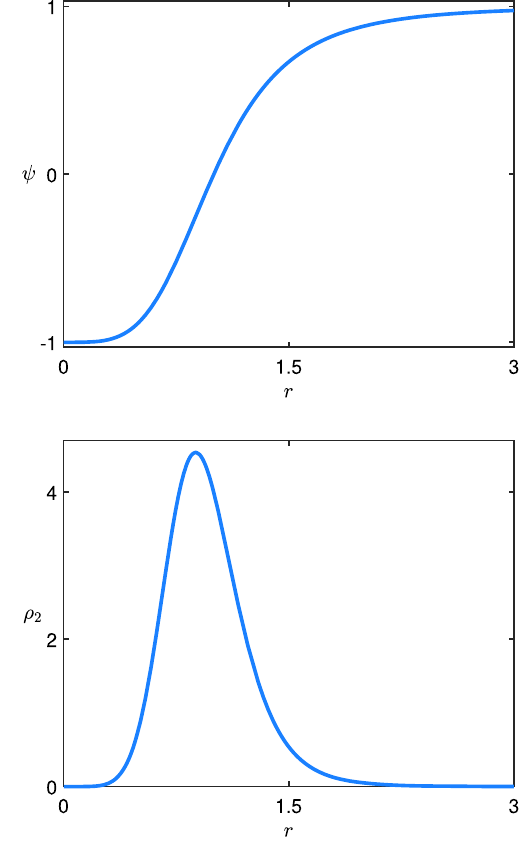
Fig. 7 The solutions ψ( r ) in Eq. (47) (top), and the energy density in Eq. (48) (bottom) for α =